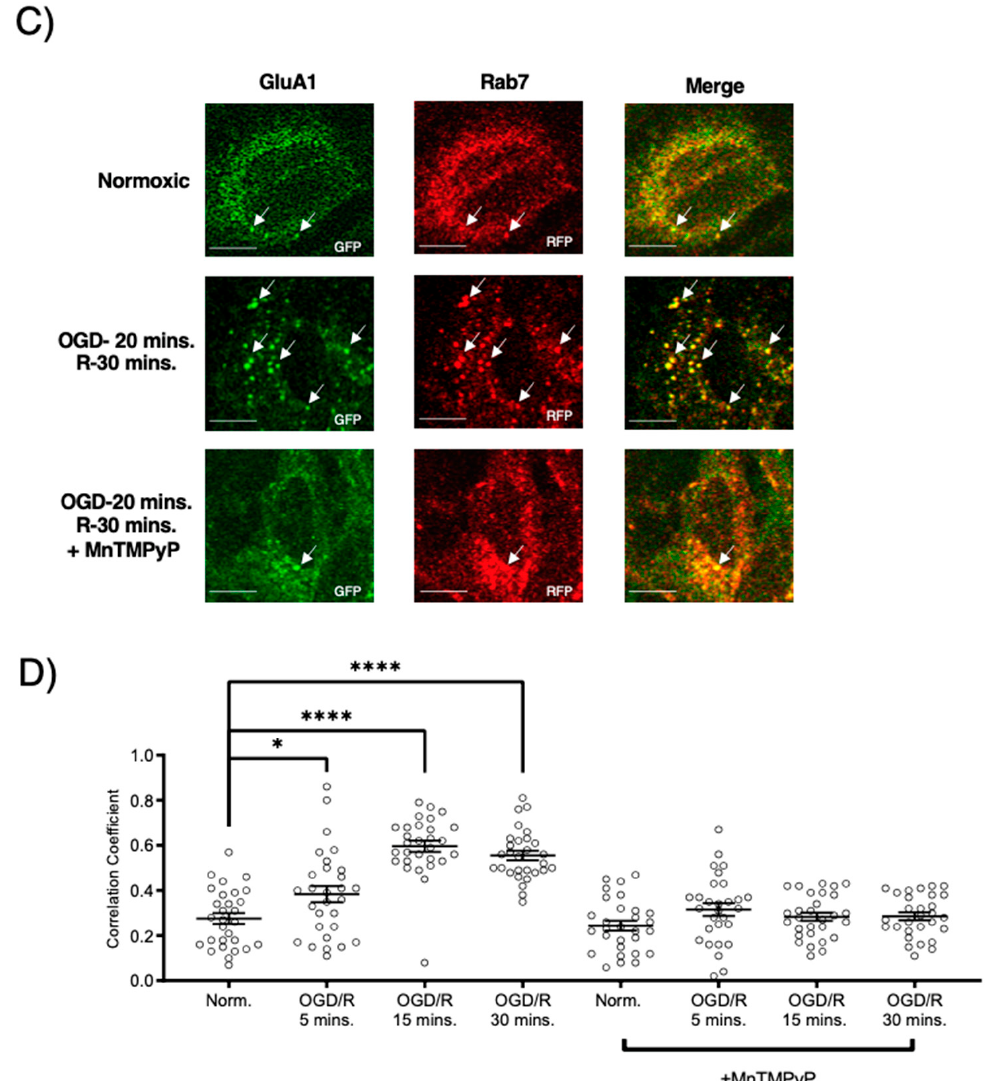
Figure 5. MnTMPyP prevented OGD/R-induced Rab-7, late endosomal sorting of GluA1 AMPAR subunits. GluA1 was present in Rab11-positive endosomes under all conditions. U-251 MG cells transfected with GluA1-eGFP and either Rab11-RFP, a recycling endosome marker, or Rab7-RFP, a marker for late endosomes, and exposed to either normoxic or OGD/R conditions. ( A ) High colocalization between GluA1 and Rab11 under both normoxic and OGD/R condition, unaffected by MnTMPyP treatment. ( B ) Quantification of ( A ) microscopy experiments (n = 30). ( C ) Increased colocalization between GluA1 and Rab7, indicating lysosomal degradation, maximally at OGD/R-15 min; the effect was ameliorated with pretreatment of MnTMPyP. ( D ) Quantification of microscopy (n = 30) results from ( C ). * p < 0.05; **** p < 0.0001; ns denotes no significance; ANOVA with Tukey’s post hoc test comparing OGD/R conditions corresponding to control (normoxic ± MnTMPyP). Data are expressed as mean ± SEM . Scale bar is 100 µm. Arrows indicate colocaliza- tion.